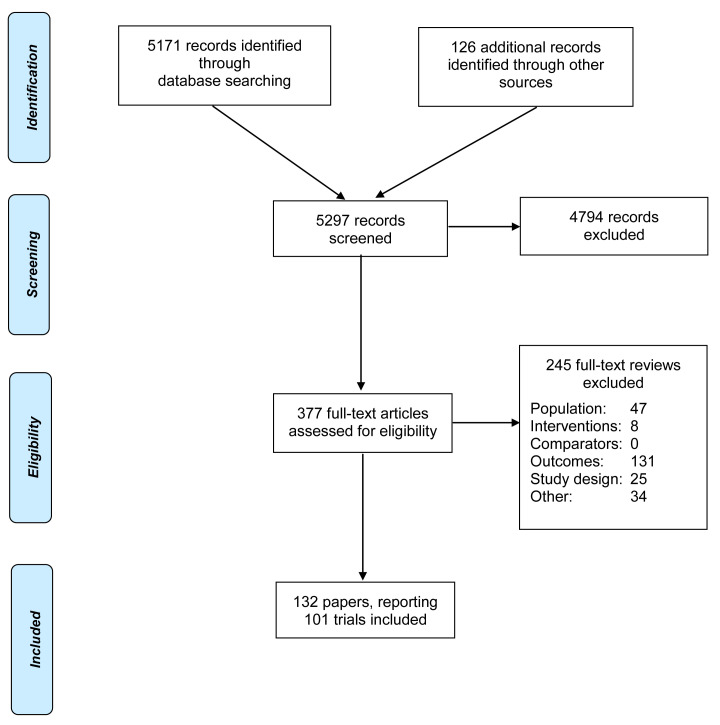
Study selection.